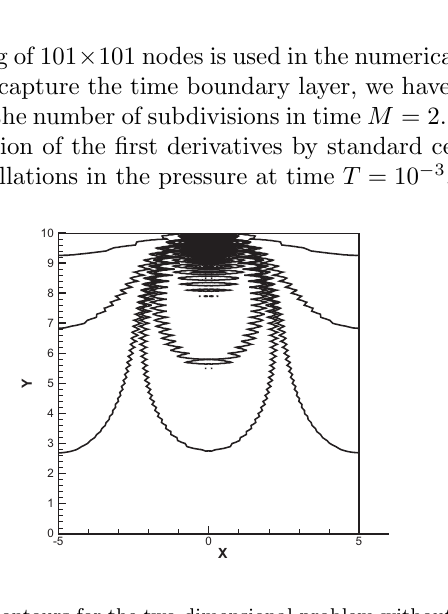
Figure 11. Pressure contours for the two-dimensional problem without stabilization term. These unphysical oscillations in the pressure are eliminated completely adding the stabilization term to the first equation as can be seen in Figure